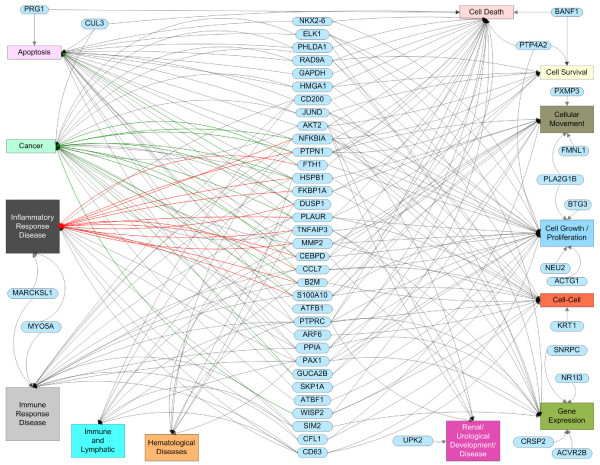
Primary functions associated with PAR1-dependent genes. The experimental datasets of PAR1-dependent genes was used to query the Ingenuity Pathways Analysis [IPA] and overlaid with primary functions and diseases.